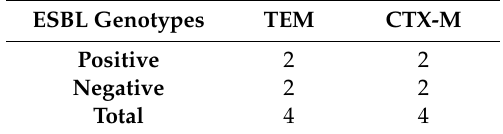
Table 3. Distribution of the bla TEM and bla CTX-M genes among E.